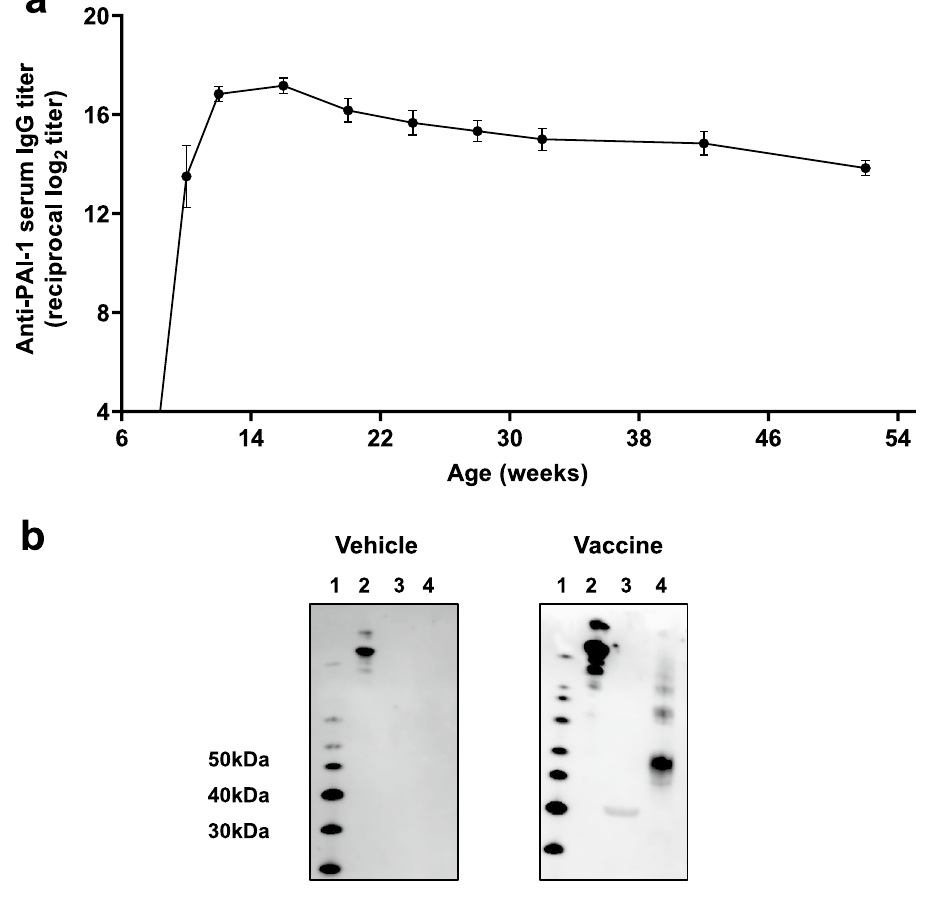
Figure 1. Evaluation of PAI-1 vaccine-elicited antibodies in mice. ( a ) Mice ( n = 6 per group) received PAI-1 vaccine at 6, 8, and 10 weeks of age, after which serum samples were obtained at 4-week intervals from 12 to 52 weeks of age, and antigen-specific IgG antibody titers were evaluated by using ELISA. ( b ) Western blotting analyses evaluated whether IgG antibodies present in the serum of mice immunized with PAI-1 vaccine or KLH vehicle bound the vaccine antigen or recombinant whole PAI-1. Data are expressed as mean ± SEM (error